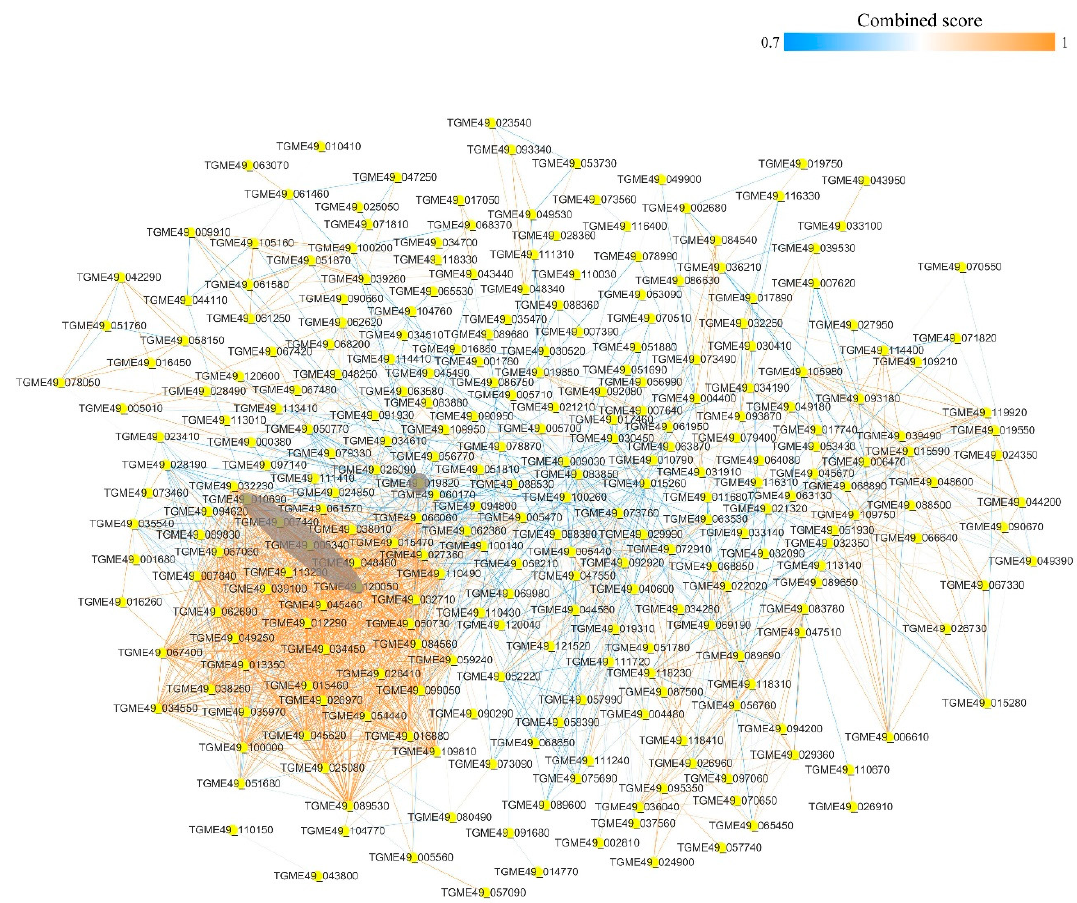
Figure 5. Protein–protein interaction network of the acetylated proteins in RH strain. Nodes represent the acetylated proteins and edges represent interactors between acetylated proteins. The color of the edges denotes the combined score of interactors. The grey color indicates the major/hub nodes of the protein-protein interaction network.